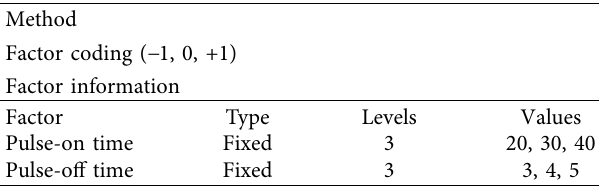
Table 17: Factor information for mild steel.